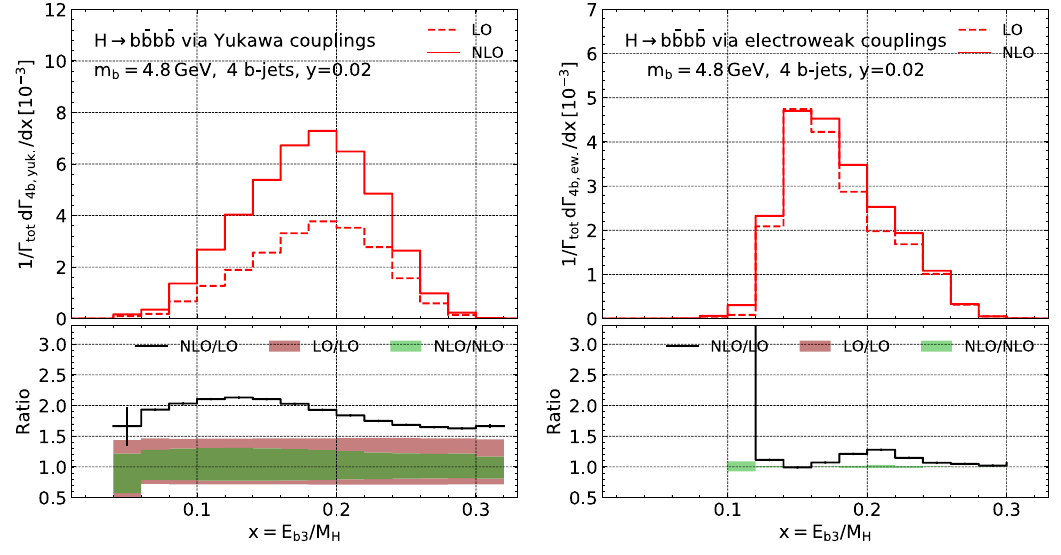
Figure 9 . Similar to figure 7 for distribution as a function of the energy of the third-leading b -jet.